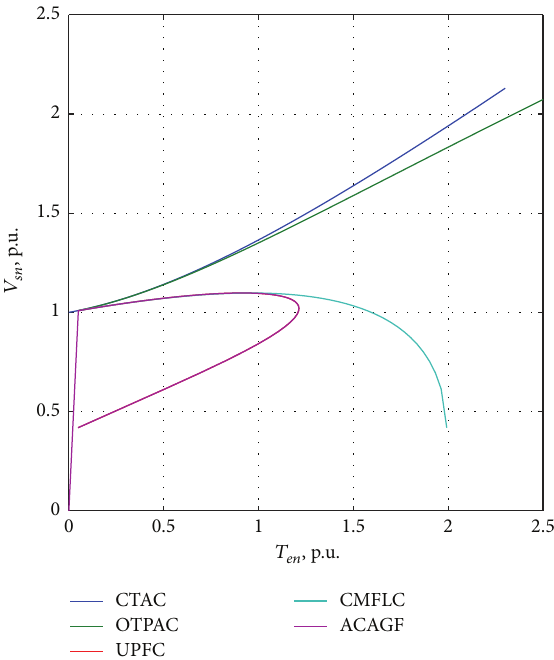
Figure 9: Current requirement for five different control strategies as a function of normalized torque.